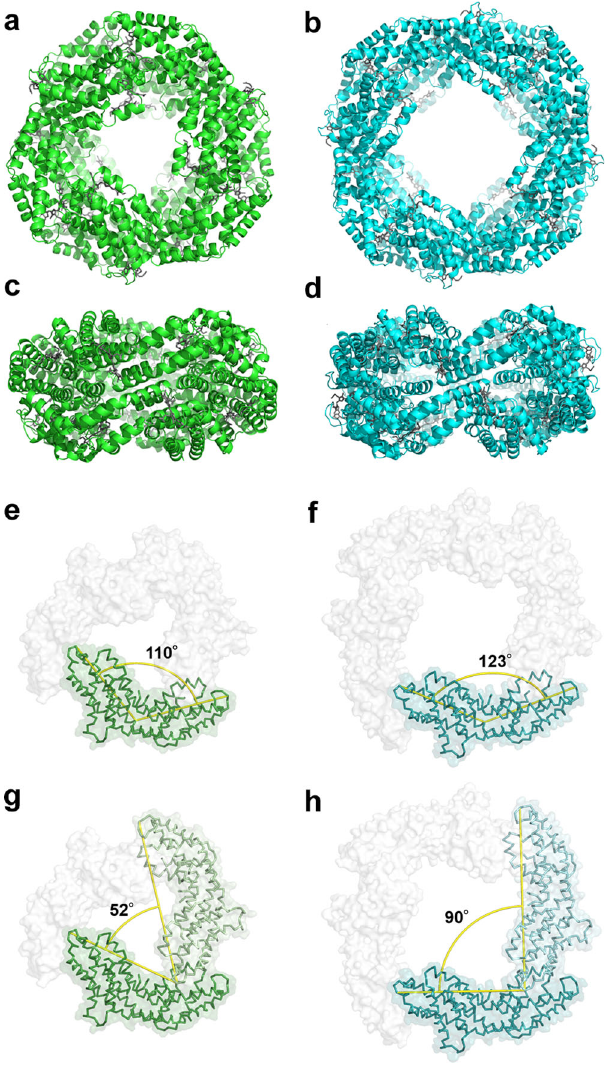
Fig. 1 Crystal models of Tl CPC-6 and Tl CPC-8. Top and side views of Tl CPC-6 ( a , c ) and Tl CPC-8 ( b , d ). Dihedral angles of monomers in Tl CPC- 6 ( e ) and Tl CPC-8 ( f ). Angles between adjacent monomers in Tl CPC-6 ( g ) and Tl CPC-8 ( h ). The main and side chains of Tl CPC-6 and Tl CPC-8 are represented by green and cyan ribbon models, respectively. PCBs are represented by grey lines. Yellow lines are guides for measuring